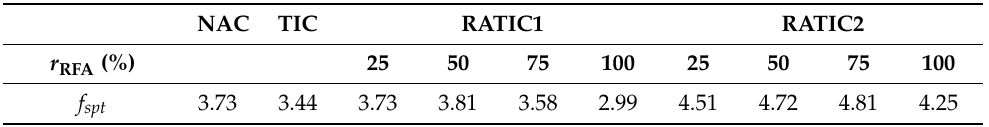
Table 6. Splitting tensile strength of RATIC (MPa).